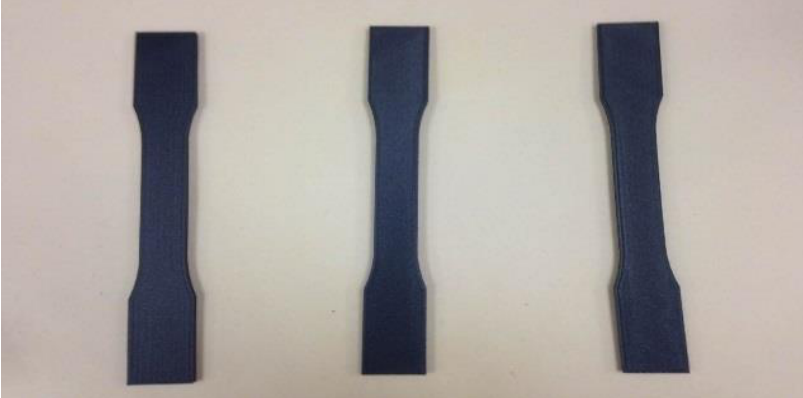
Figure 1. ASTM D 638 Tensile Specimens (6 inches long).